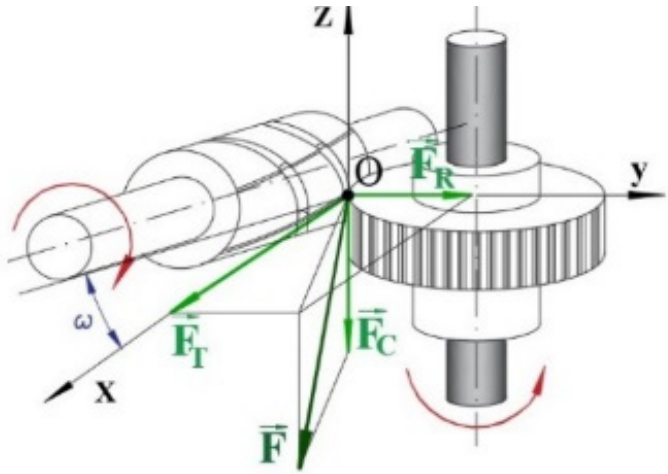
Figure 1. The schematic representation of the workpiece cutting force.